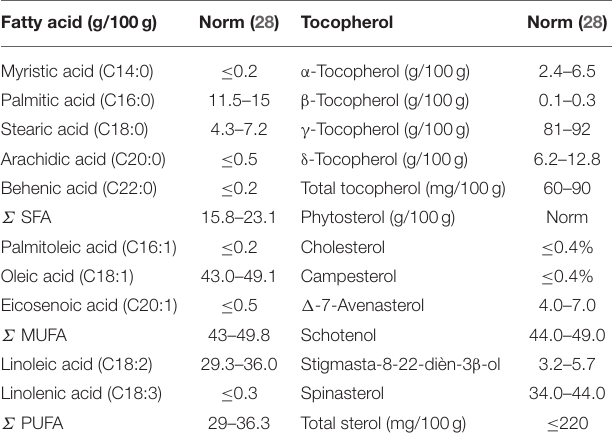
TABLE 1 | Physicochemical parameters of cosmetic and edible argan oil. Physicochemical properties